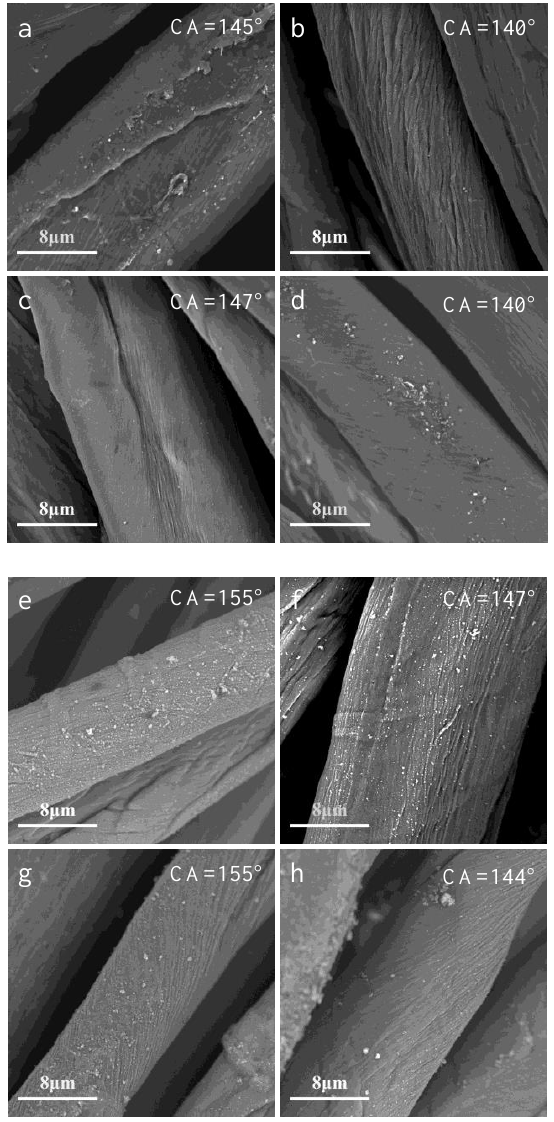
Figure 2. The effect of the plasma cycle time on the contact angle and surface morphology of N 2 plasma-treated cotton fabric: ( a ) 20%; ( b ) 40%; ( c ) 60%; ( d ) 80%; O 2 plasma-treated cotton: (e) 20%; ( f ) 40%; ( g ) 60%; (h) 80%.